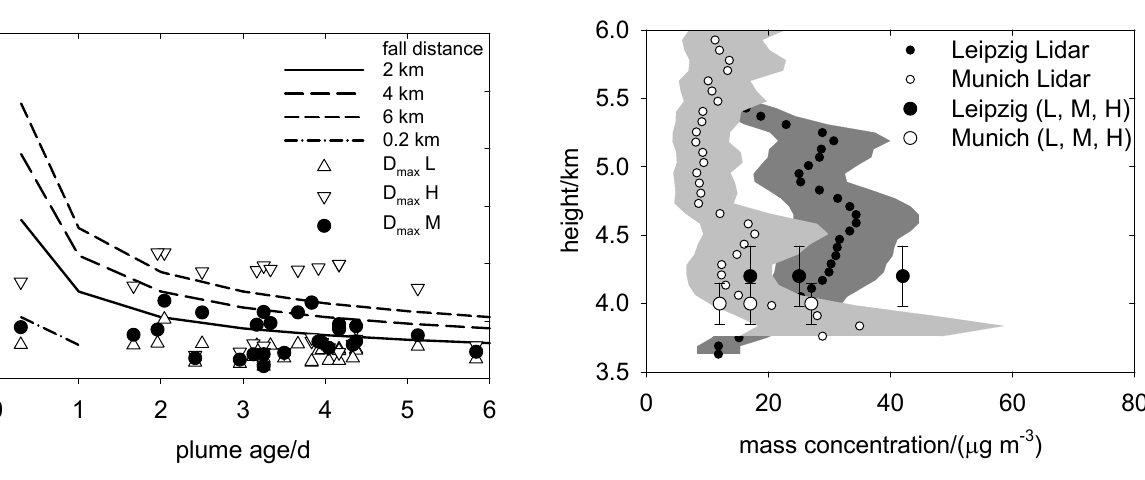
Fig. 21. Sedimentation-limited particle diameter D max as a function of plume age and fall distance below plume top height. Also plotted are the diameters D max for which the measured volume size spectra assume their maximum value from the FSSP data for analysis cases L, M and H.